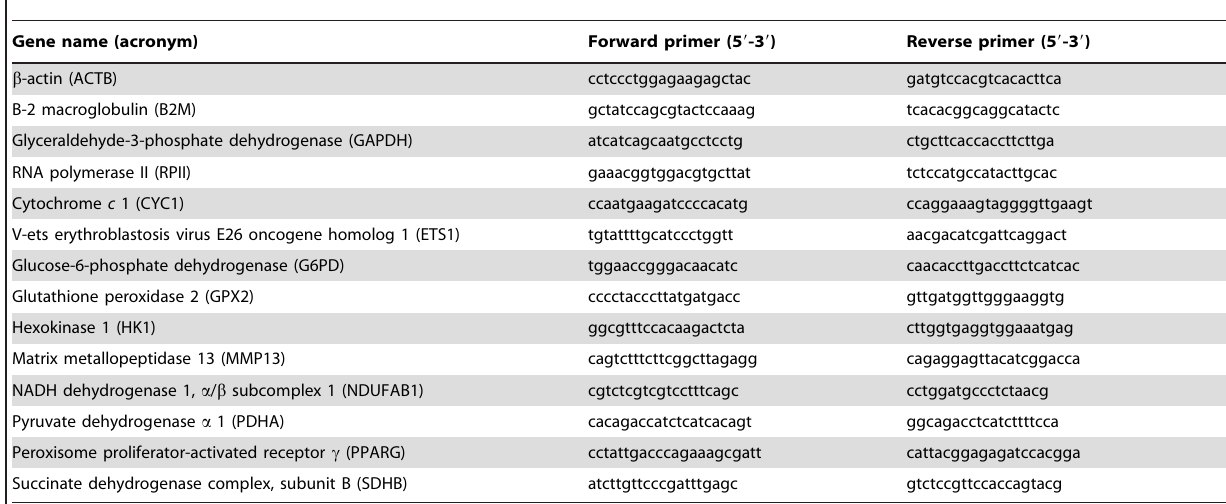
Table 5. Primer sequences used for real time